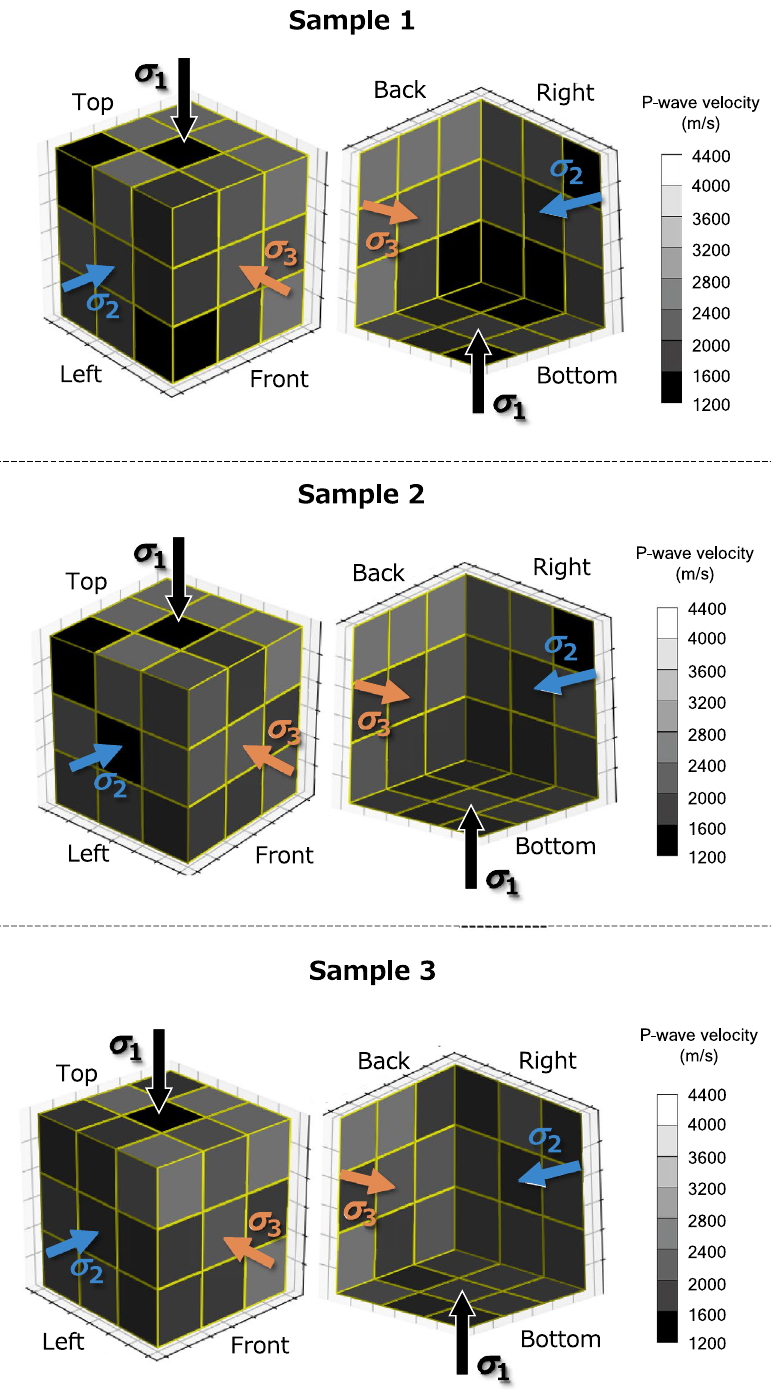
Fig. 3 Estimated P-wave velocity distributions for